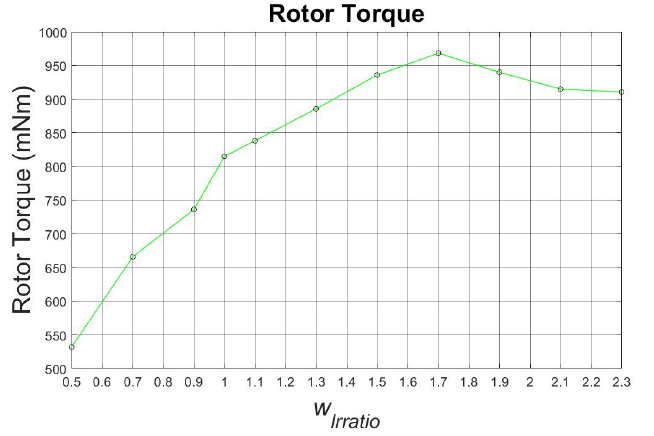
Figure 10. Rotor torque over the parameter w lrratio .